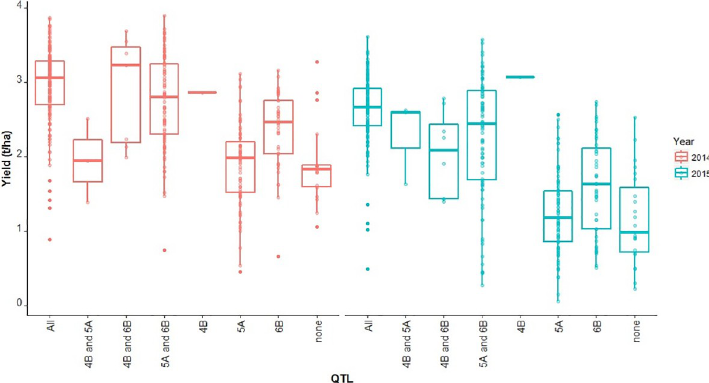
Fig 4. Boxplot of yield in 2014 and 2015 for accessions carrying favorable haplotypes at different yield QTL combinations.